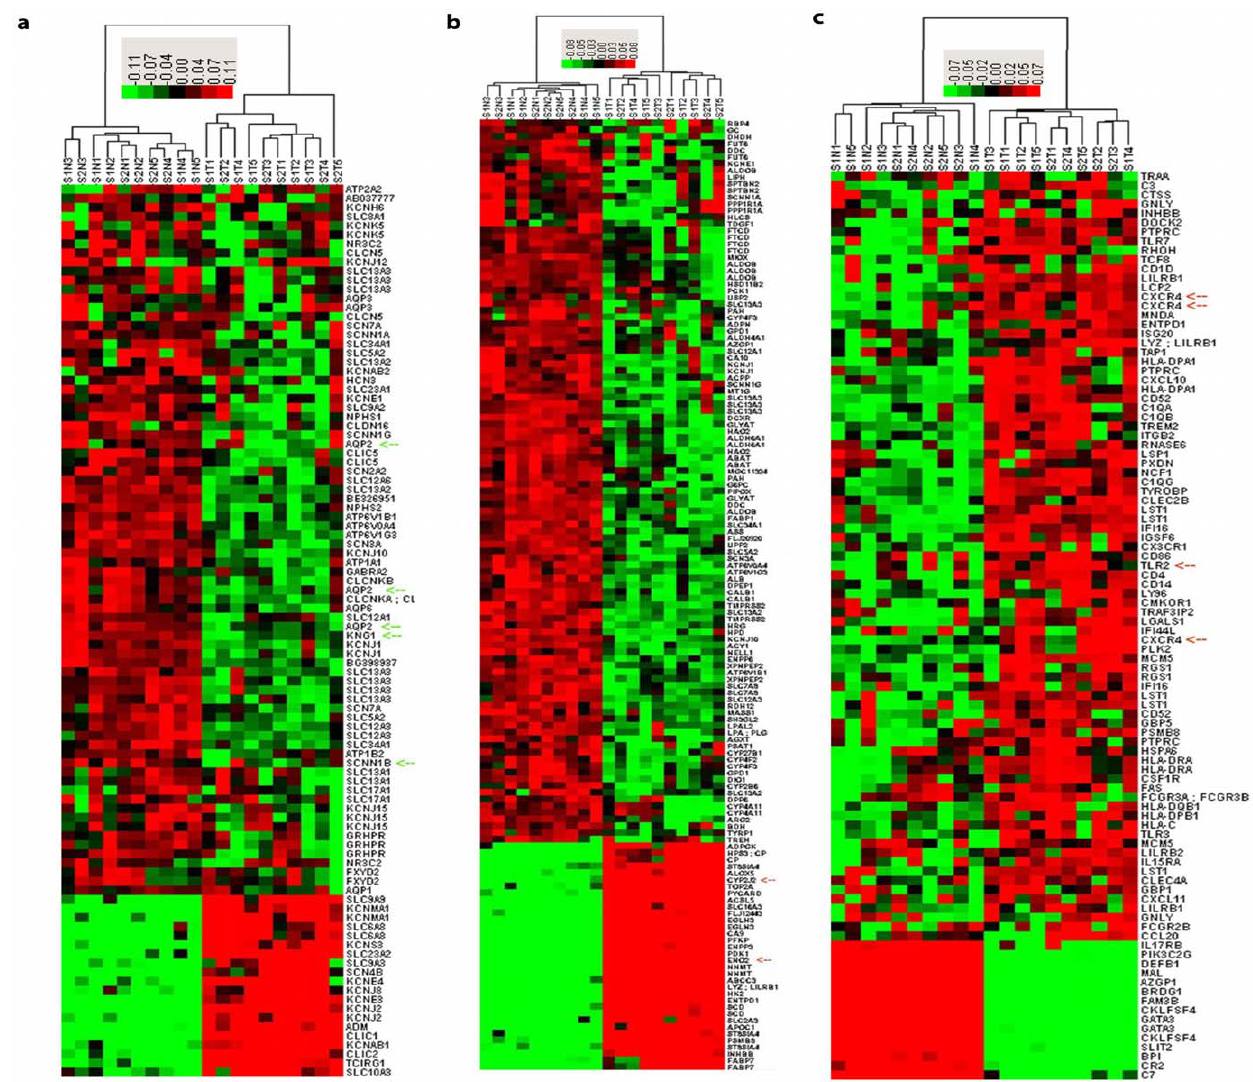
Figure 1. Heatmap signature of clear cell renal cell carcinoma. a. Normal renal function-related pathway gene expression signature. b. Metabolic pathway gene expression signature. c. Immune pathway gene expression signature. Upregulation of genes is indicated in red, downregulation is indicated in green, and a similar expression is indicated in black, as generated by Cluster 3.0.